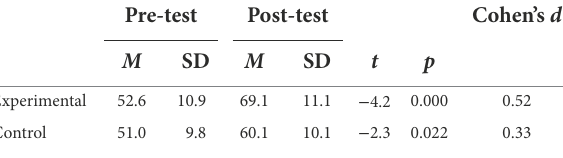
TABLE 2 Paired samples t -test results, examining the differences between the pre- and post-tests of the two groups on the writing performance.